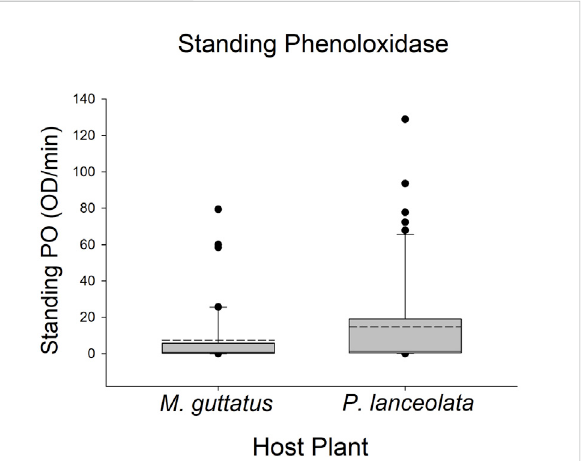
FIGURE 3 Boxplots representing the data for standing phenoloxidase activity for each host plant. Solid lines in the boxes represent the medianstandingPOanddottedlinesrepresentthemeanstandingPO. Standing PO was higher on Plantago lanceolata